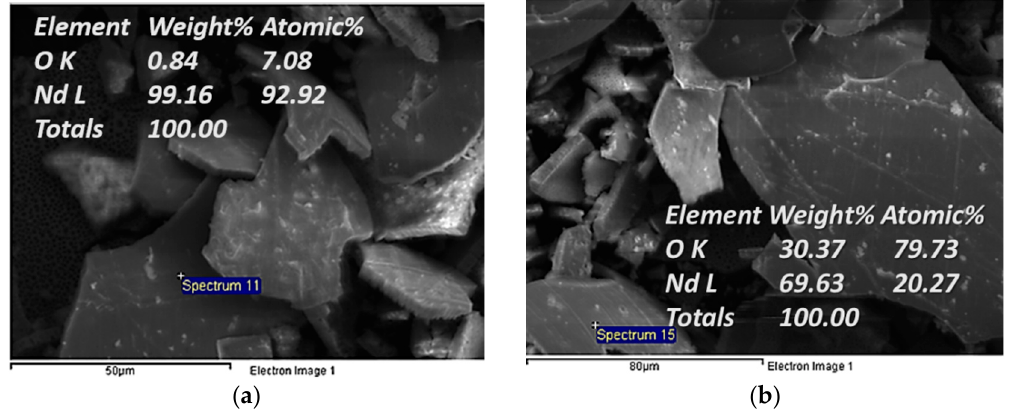
Figure 9. SEM-EDS analysis of the electrodeposits produced ( a ) without and ( b ) with stirring.